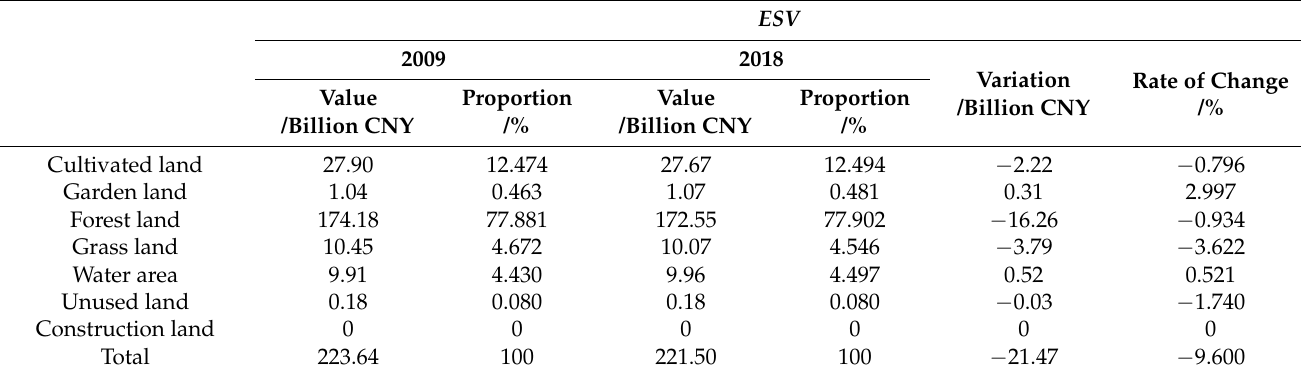
Table 4. Changes of the total ecosystem services value in Guizhou Province in 2009 and